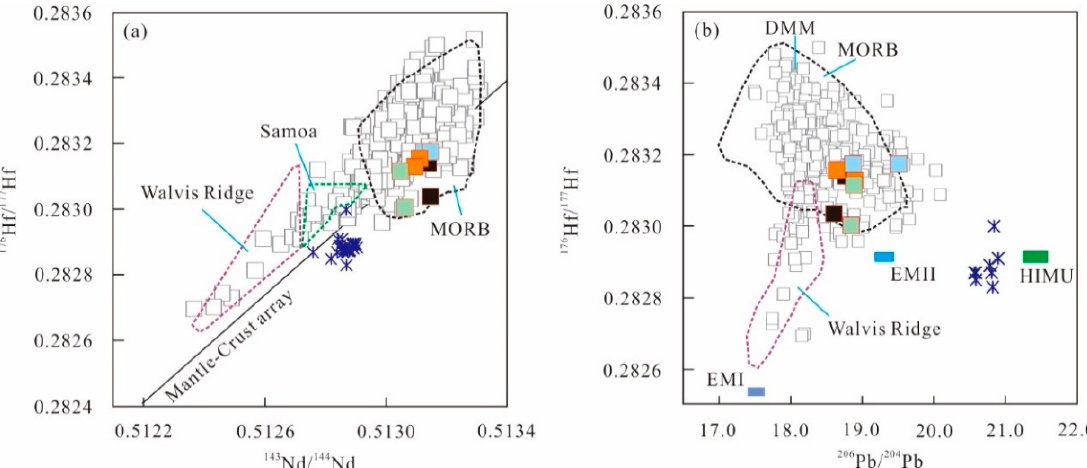
Figure 4. 143 Nd/ 144 Nd versus 176 Hf/ 177 Hf ( a ) and 206 Pb/ 204 Pb versus 176 Hf/ 177 Hf ( b ) diagrams (after [42,47,54] and references therein) of the basalts from the SMAR at 18–21°S. The Atlantic MORB and the St. Helena igneous rock values are from http://georoc.mpch-mainz.gwdg.de/georoc/Entry.html. Symbols are the same as in Figure 2.